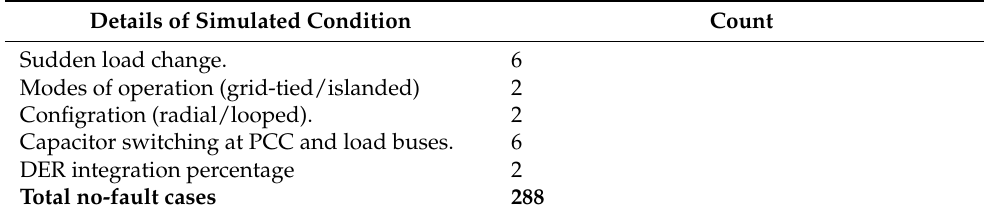
Table 2. Simulated non-fault scenarios on the IEC MG test system.